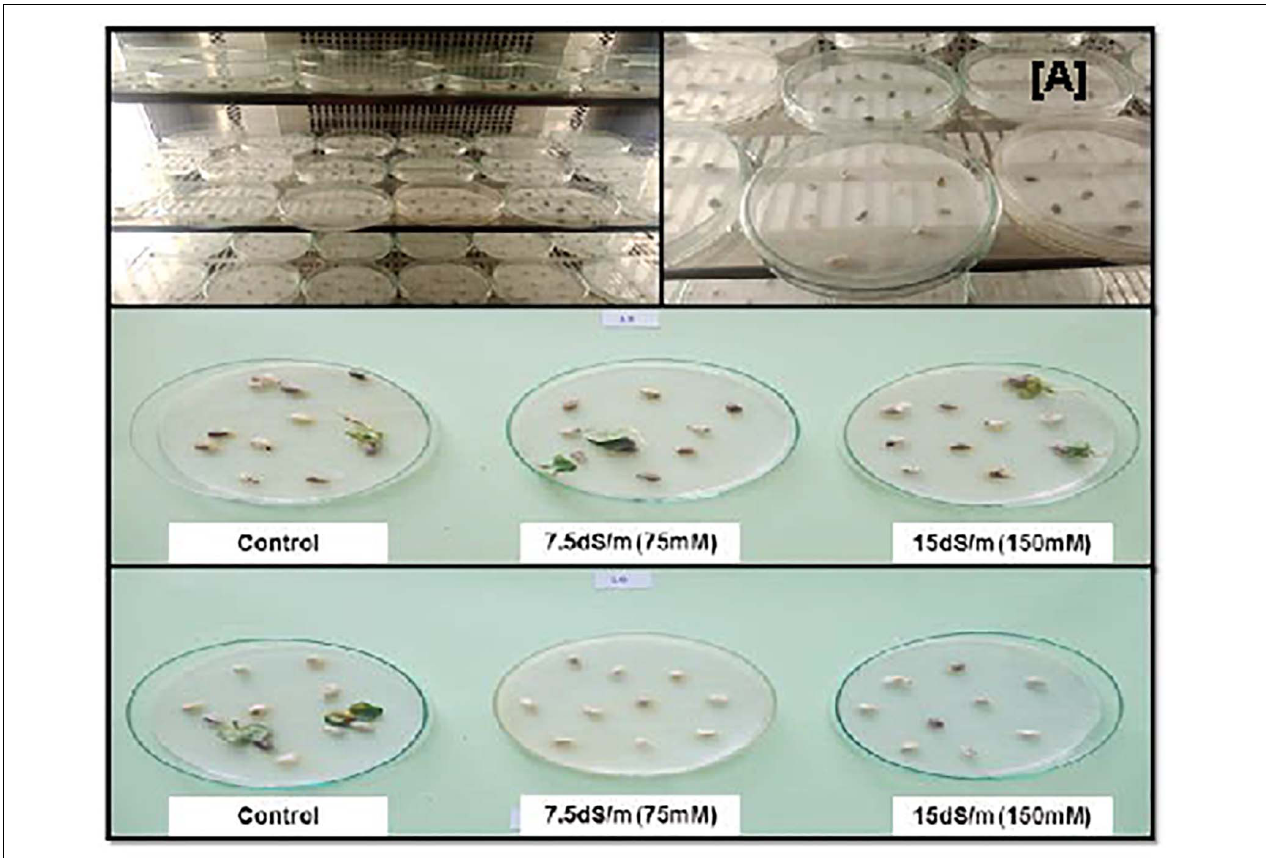
FIGURE 3 | (A) Cotton seeds germination in growth chamber under salinity stress and normal condition. The tolerant cotton seed germination occurs in both salt stresses but no germination in sensitive